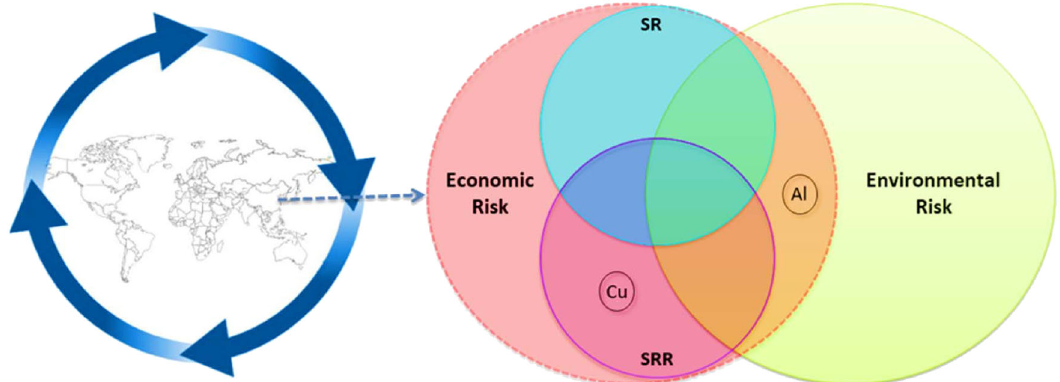
Fig. 6 National level criticality assessment using the multiple-metal approach. China ’ s criticality status is demonstrated under the multiple-metal